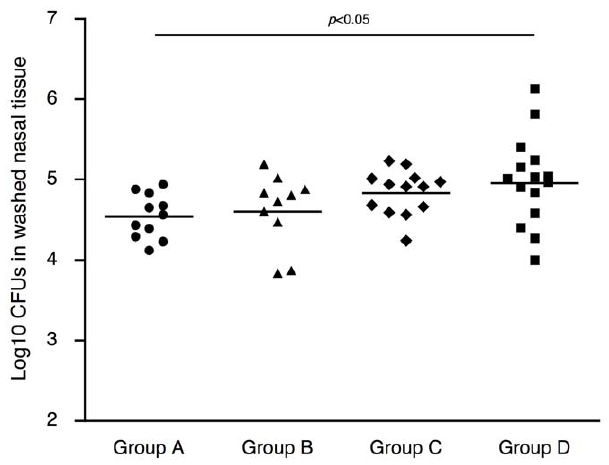
Figure 5. Protection against nasal carriage of pneumococci by maternal immunization with PspA among offspring. Offspring at 7-day-old were intranasally challenged with 1 6 10 5 CFU TIGR4 strain (5 m l/mouse) without anesthesia. Two days after challenge, nasal washes and homogenized washed nasal tissues were collected and the numbers of pneumococci colonies were determined. No evidence of protection was observed in CFUs in nasal washes (not shown). Results are shown for CFU in homogenized washed nasal tissue. Each dot represents the Log 10 CFU/mouse. Each horizontal line depicts the median Log 10 CFU/mouse. Group A (n=11), B (n=10), C (n=13), and D (n=15) mice were produced in the same manner as the corresponding groups in figure 3. Group A differed from Group D at p , 0.05 by Kruskal- Wallis test with Dunn’s multiple comparison test.